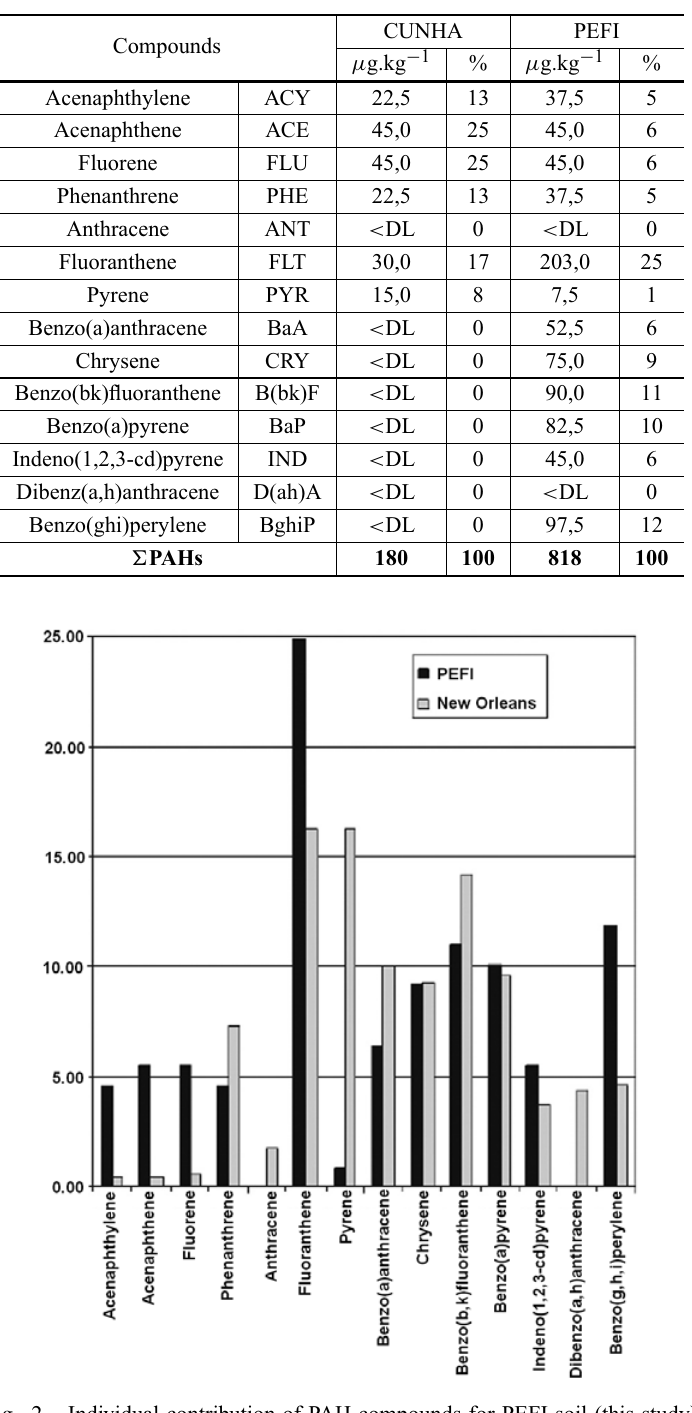
Fig. 2 – Individual contribution of PAH compounds for PEFI soil (this study) and New Orleans urban soils (Mielke et al. 2004) (values in % of the (cid:1)